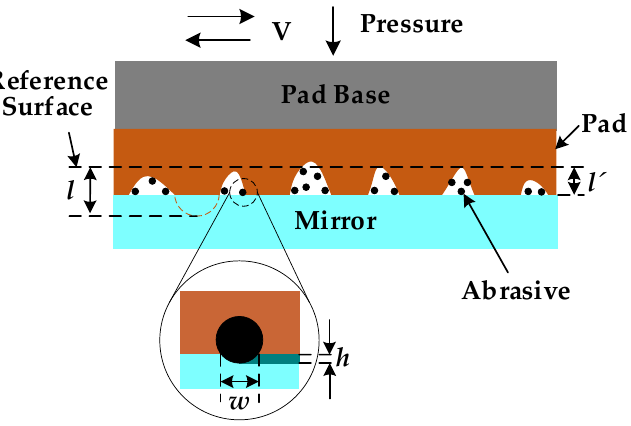
Figure 4. Schematic diagram of mechanical action.